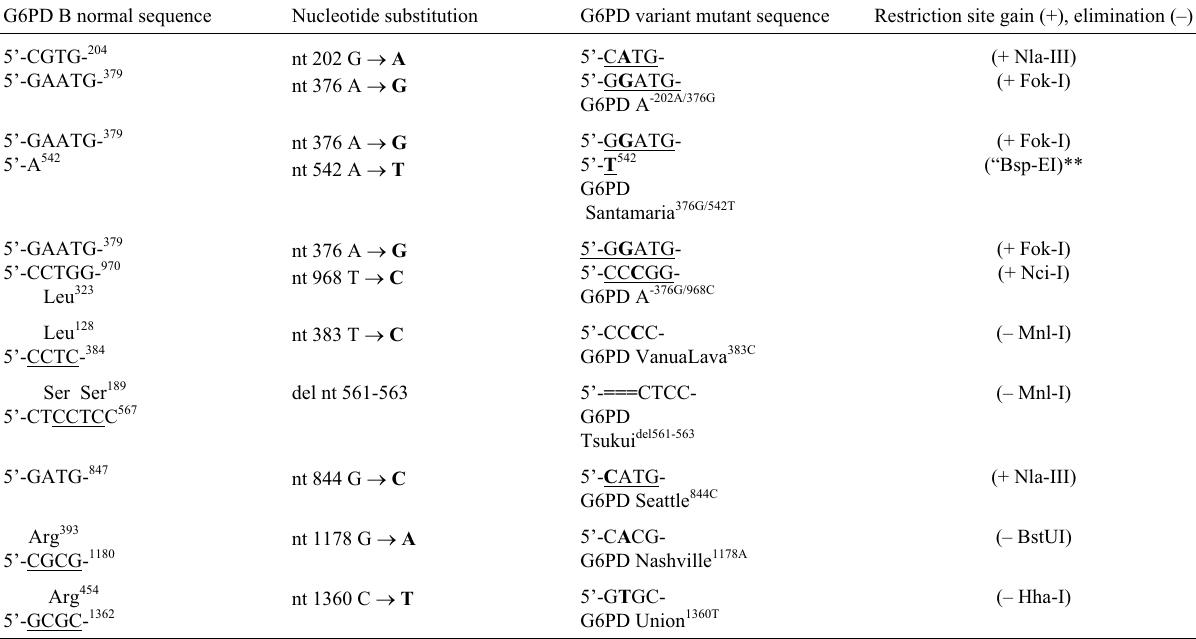
Table1 -Glucose-6-phosphatedehydrogenase(G6PD)mutationsdetectedbyPCR-restrictionenzymeanalysis(PCR-REA).Nucleotidesubstitutionsare in bold type and the restriction endonucleases recognition sequences are underlined. G6PD B normal